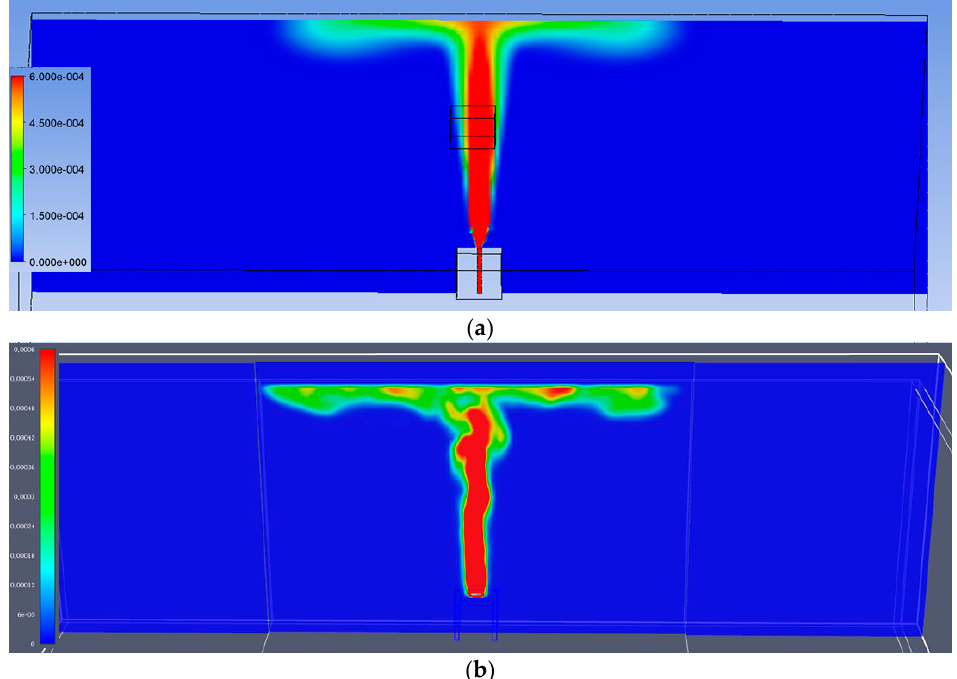
Figure 17. Comparison of hydrogen dispersion for 1.5% concentration of LEL for time 100 s: ( a ) propane release calculated with Ansys software; ( b ) propane release calculated with FDS software.